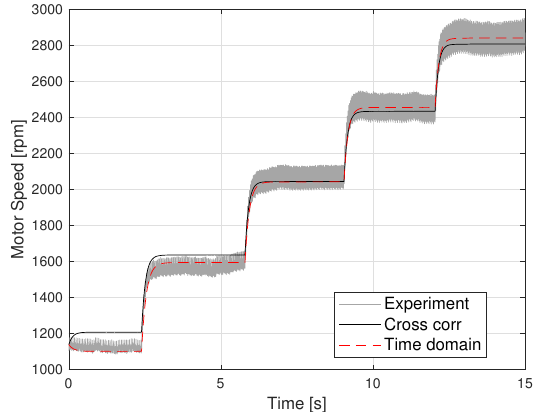
Figure 10. Motor speed time history of the staircase test.